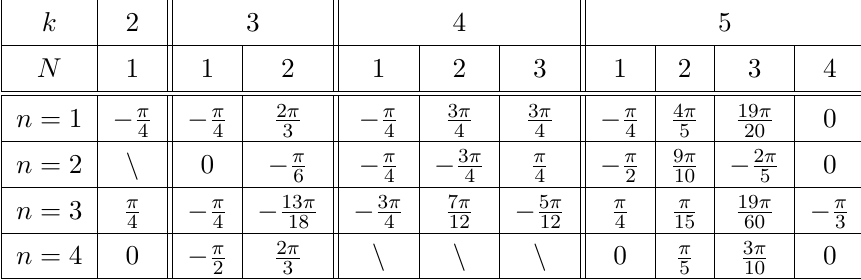
h i U ( N ) with b = 1 . \ means that the value of the k, 0 and U ( | k | − N ) gauge group does not hold. k, 0 − k, 0